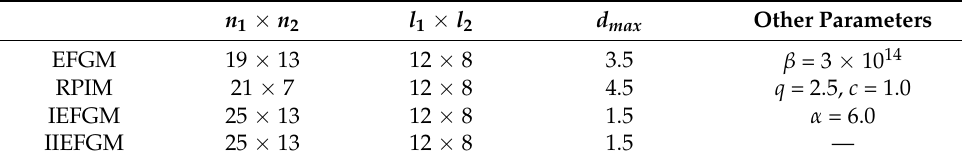
Figure 5. Cantilever beam under uniform load at its upper boundary. Table 3. Optimal value of computing parameters in this